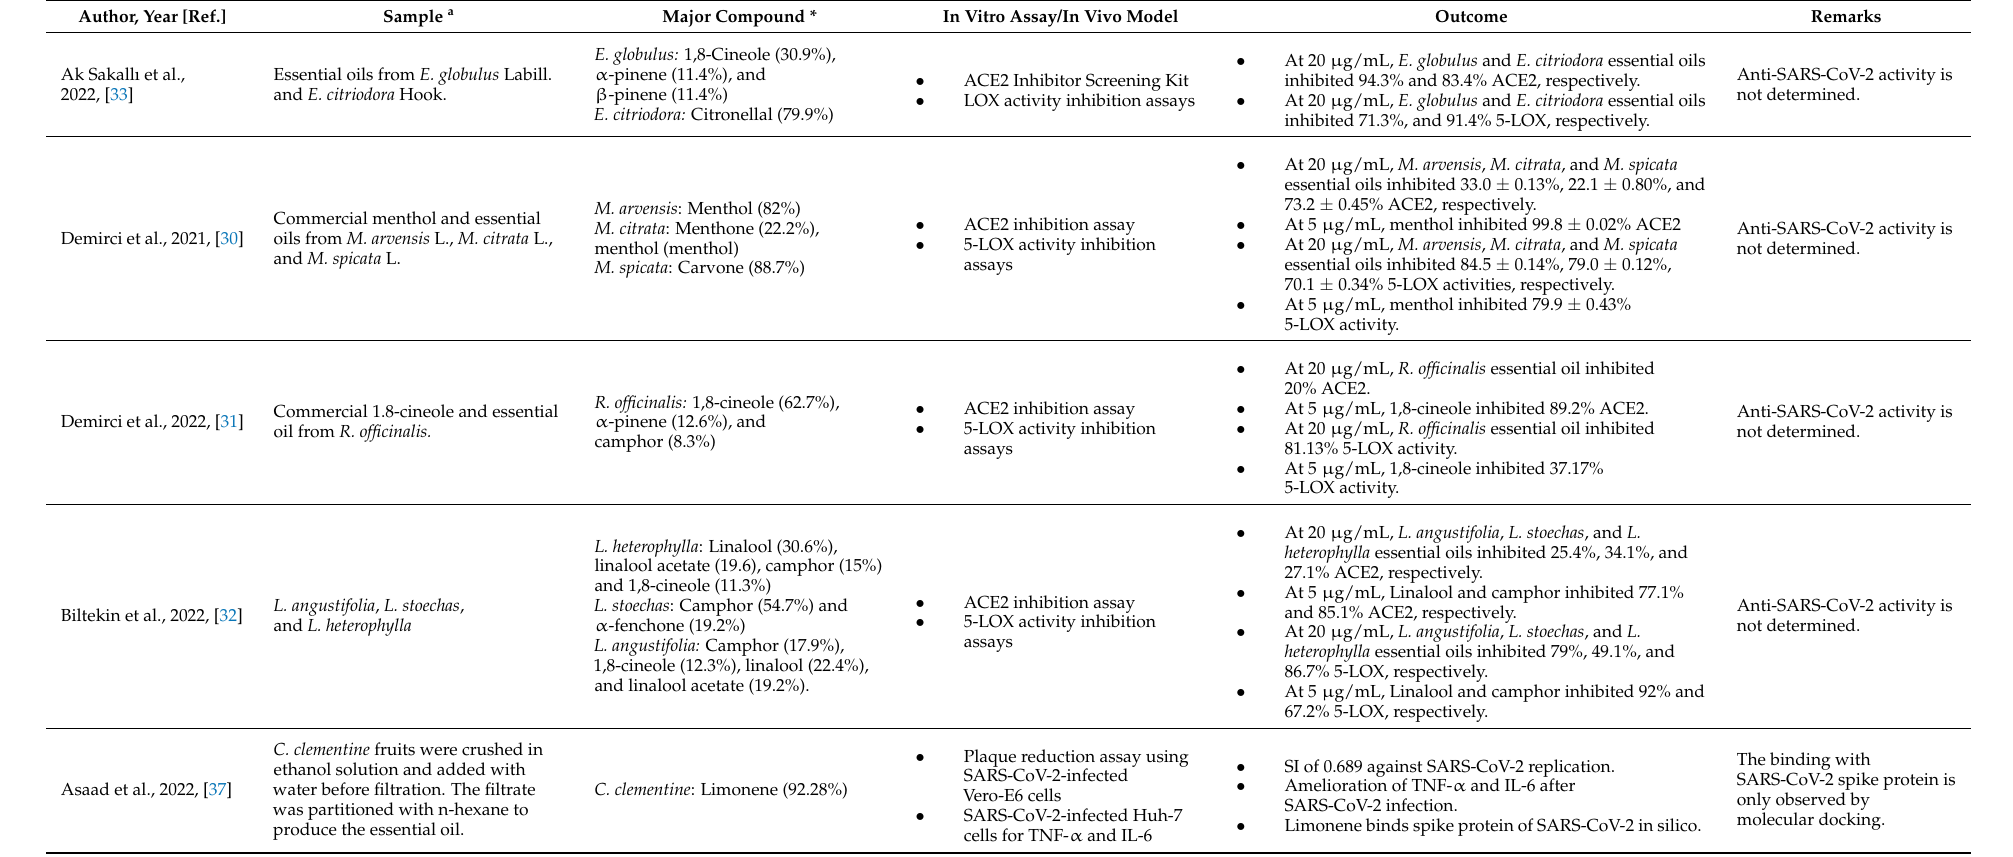
Table 2. Studies reporting molecular interactions of essential oils with COVID-19-related proteins selected based on systematic literature search